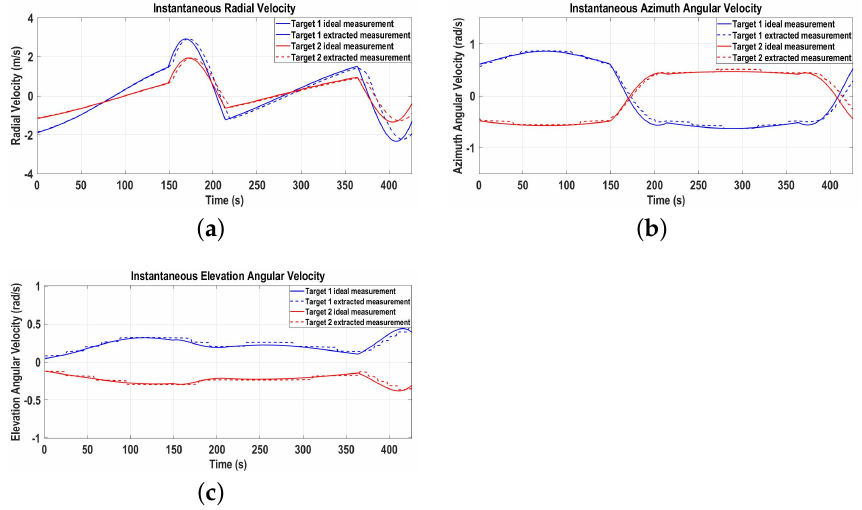
Figure 10. Three-dimensional velocity measurements for Scenario 2. ( a ) Radial velocity measurement; ( b ) Azimuth angular velocity measurement; ( c ) Elevation angular velocity measurement.